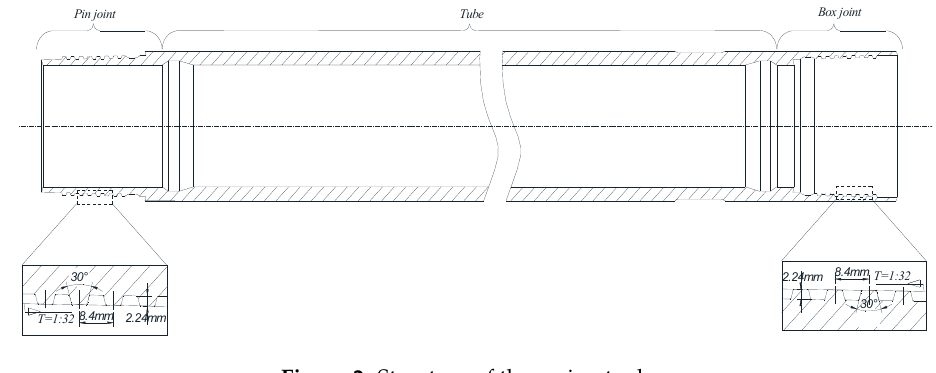
Figure 2. Structure of the coring tool.